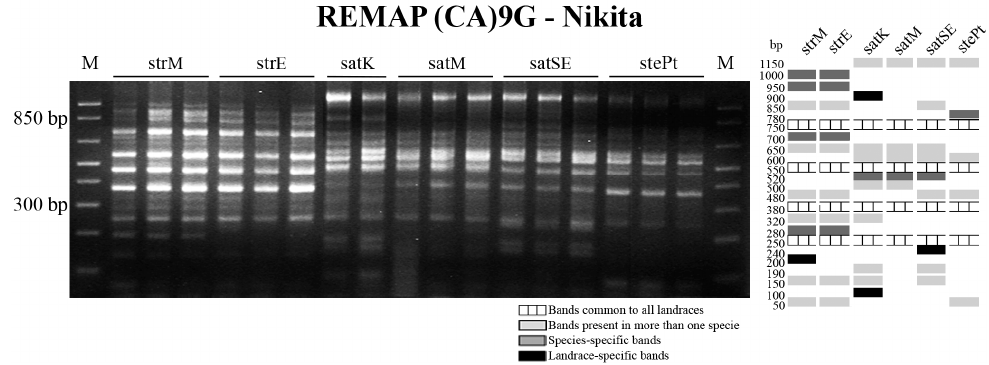
Figure 7. REMAP banding profiles obtained with primer for Nikita retrotransposon LTR and (CA)9G microsatellite anchored primer and correspondent schematic representation. M: molecular marker 1